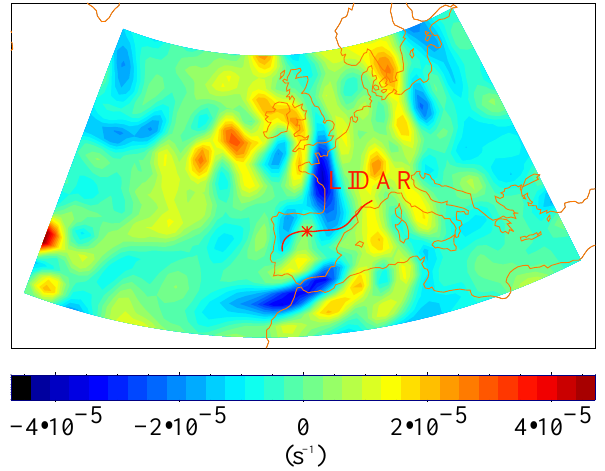
Fig. 11. Divergence of the horizontal-velocity analyzed field on 2 September 1997 at 14:00 UTC. The trajectory of the observed ray is also